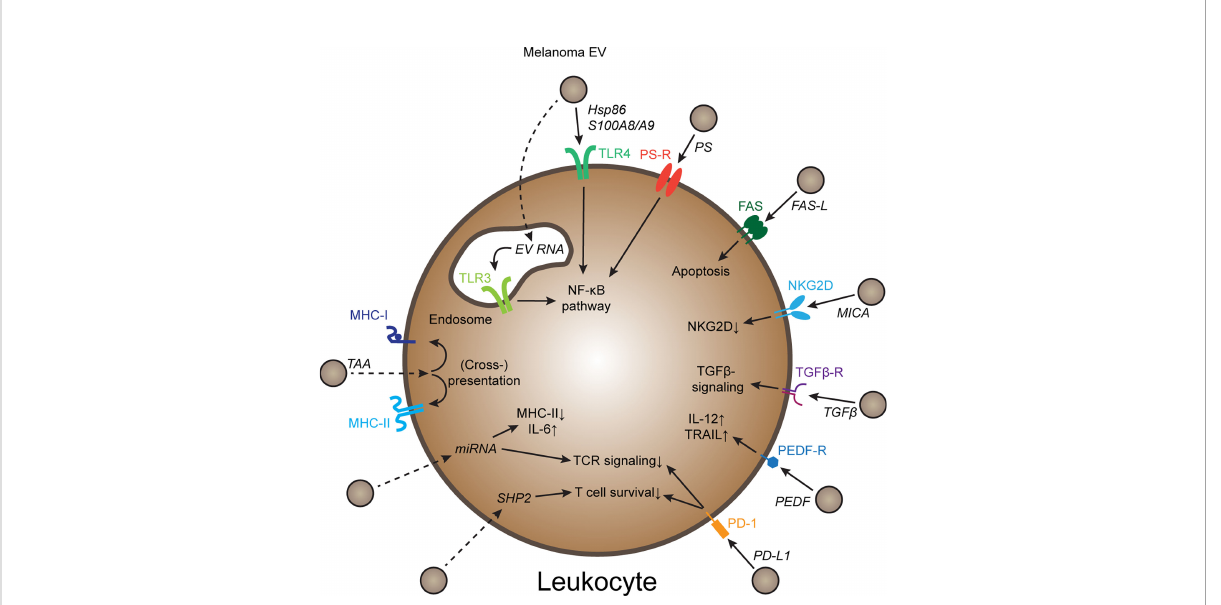
FIGURE 1 Mechanisms of melanoma EV-mediated immune cell regulation Schematic representation of several molecular mechanisms how melanoma- derived EVs can regulate immune cell behavior. Further explanations in the text. Dotted arrows indicate pathways that require EV uptake and release of EV cargo. PS, Phosphatidyl-serine; PS-R, PS-receptor; TAA, tumor-associated antigen; PEDF, pigment epithelium derived